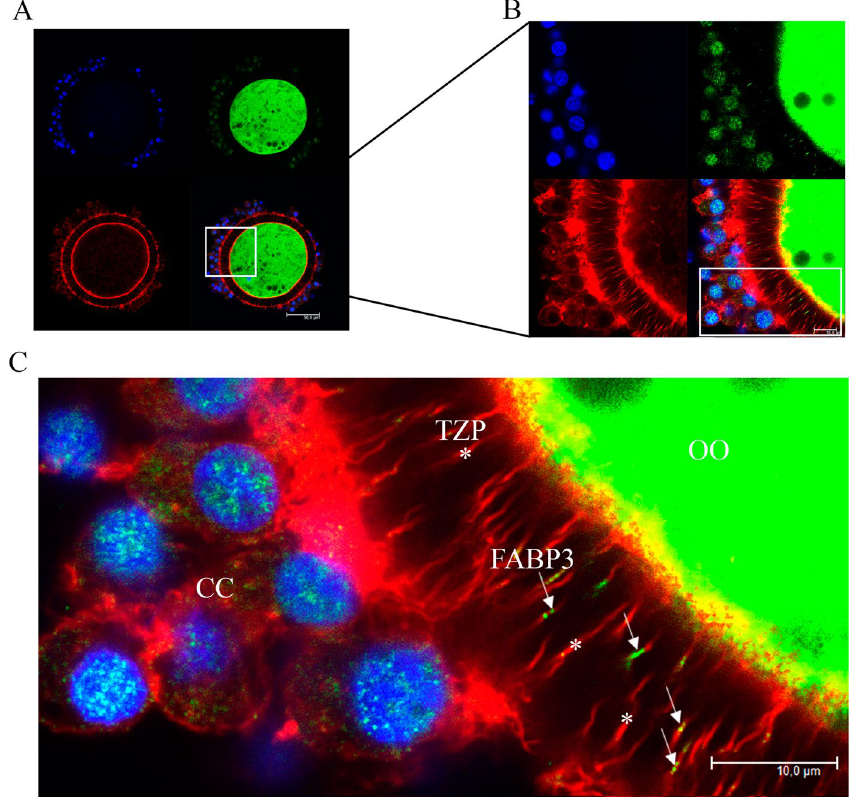
Figure 3. Confocal photomicrographs of fatty acid binding protein 3 (FABP3) immunodetection in transzonal projections (TZPs) after 9 h of in vitro maturation (IVM). FABP3 is immunostained using 488 Alexa Fluor (green); TZPs (actin) are stained with Alexa Fluor 647 phalloidin (red); nuclei are stained with DAPI (blue). ( A ) Photomicrographs of COCs after 9 h of IVM were obtained in 63x objective and ( B ) in 63x objective zoomed 3.5x. ( C ) Digital zoom showing FABP3 (arrow) along TZPs (asterisk) in the zona pellucida (OO = oocyte; CC = cumulus cells). A total of 12 COCs in vitro -matured for 9 hours were analysed and showed similar pattern; 6 additional COCs are shown in Supplementary Fig.